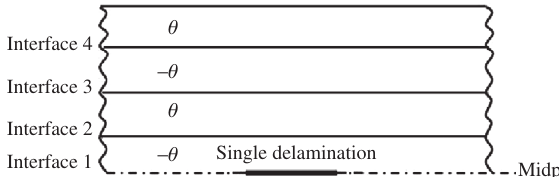
Figure 6 Interface location of the delamination for a [ θ /- θ / θ /- θ ] graphite/epoxy composite laminate.